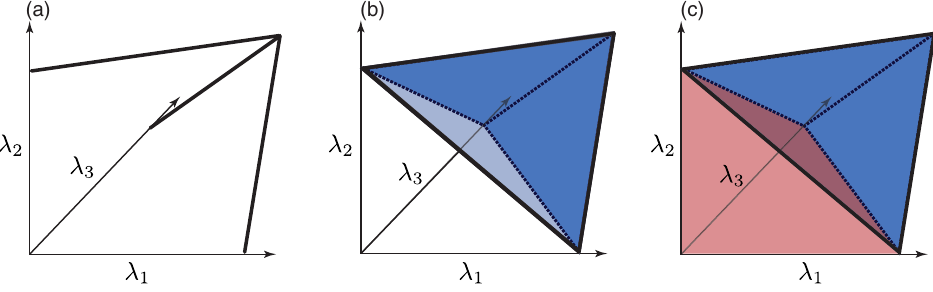
FIG. 1. Entanglement polytopes for the three-qubit case. (a) Polytope for the biseparable and separable cases ( BS and S states). There are three axes for the eigenvalues λ 1 , λ 2 , and λ 3 , and the other three lines represent the BS polytopes. Each line corresponds to one polytope. These lines converge to a point, which represents the polytope of the full separable states. (b) Polytope for the W states, represented by the blue tetrahedron, a 3D representation. (c) Polytopes for the W states (the blue tetrahedron) and the polytope for the GHZ states (the entire polytope). Points inside the red tetrahedron are guaranteed to belong to the GHZ